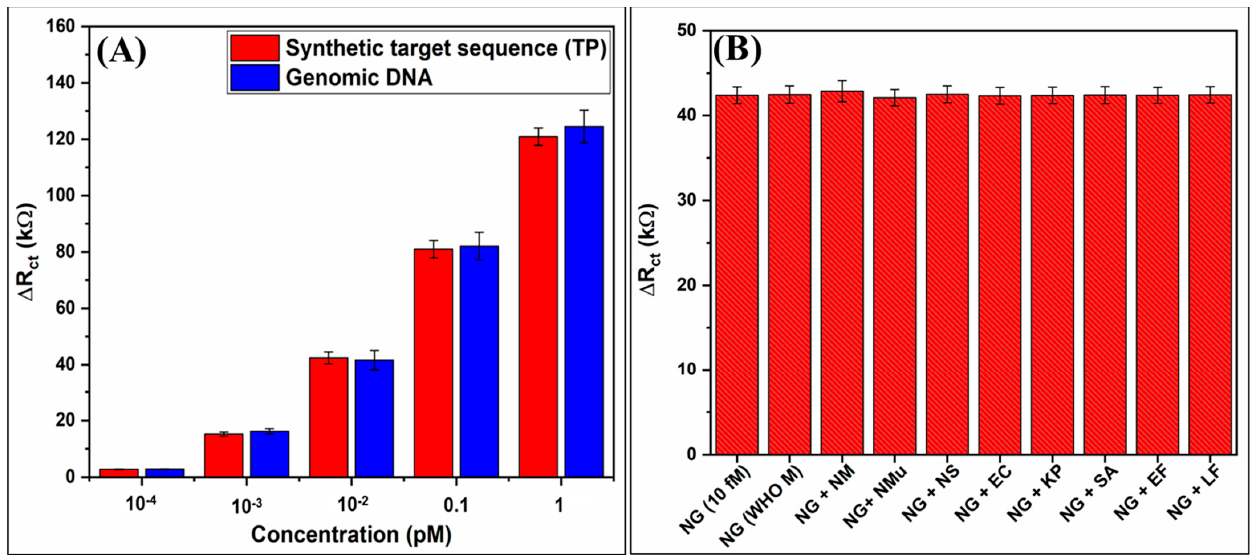
Figure 4. ( A ) Comparison between the biosensor response to synthetic TP and genomic DNA from NG for di ff erent concentrations (100 aM–1 pM). ( B ) Response of the biosensing assay to NG DNA mixed with DNA from other bacterial species. NM: Neisseria meningitidis , NMu: Neisseria mucosa , NS: Neisseria sicca , EC: Escherichia coli , KP: Klebsiella pneumoniae , SA: Staphylococcus aureus , EF: Enterococcus faecalis , LF: Lactobacillus fermentum .